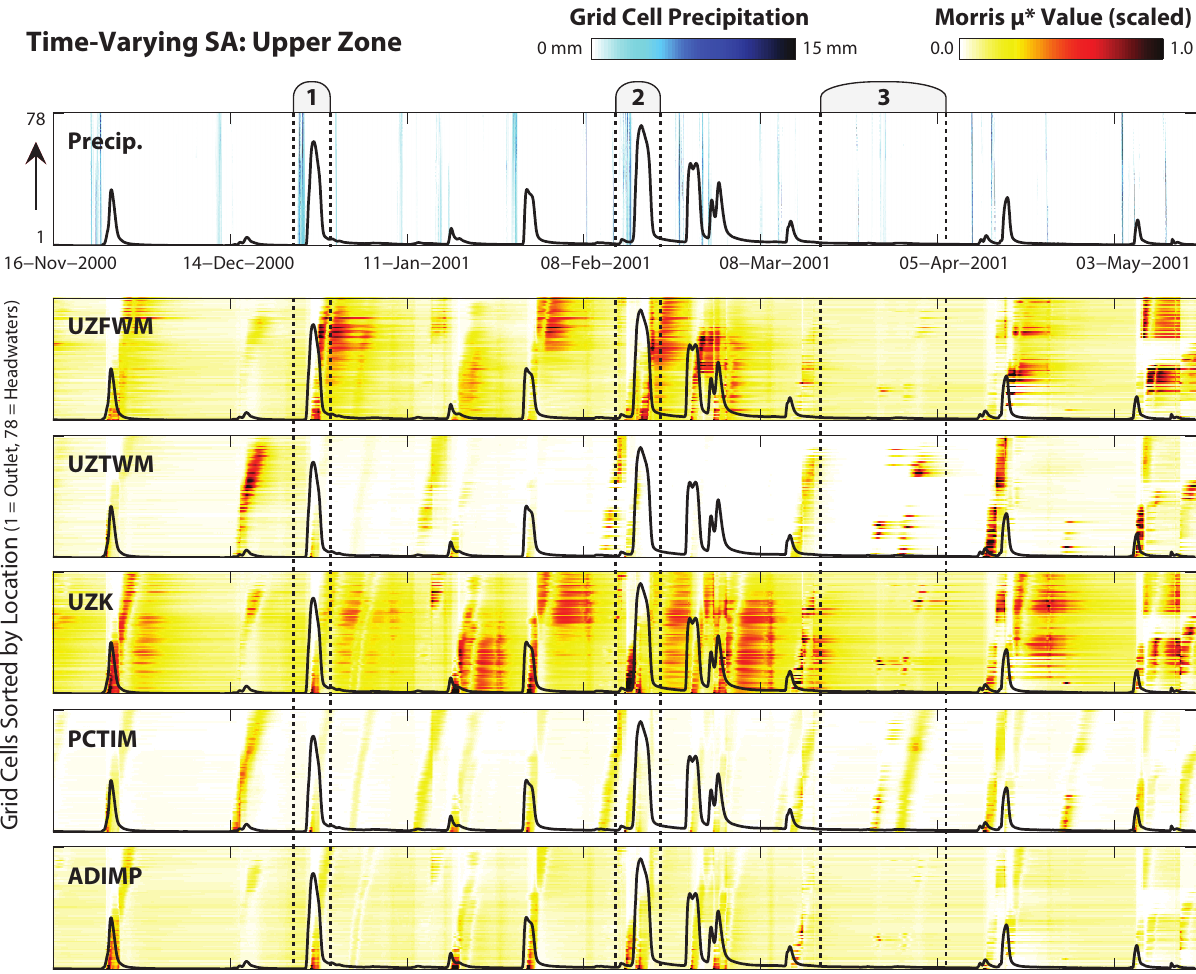
Fig. 7. Time-varying sensitivity of the RMSE metric for the five upper zone parameters of the HL-RDHM model. The indices are calculated for a 24h moving window with a 3h time step. The y axis arranges the 78 grid cells based on their distance from the watershed outlet, from the outlet ( y = 1) to the furthest headwater cell ( y = 78). The µ ∗ values from the method of Morris are scaled to the range [ 0 , 1 ] from an initial range of [ 0 , 0 . 2 ] . The parameters controlling the upper zone free water element, UZFWM and UZK, are highly sensitive during large events. The high sensitivity of these parameters typically begins near the watershed outlet during the rising limb of the hydrograph, and transitions toward the headwater cells during the falling limb.